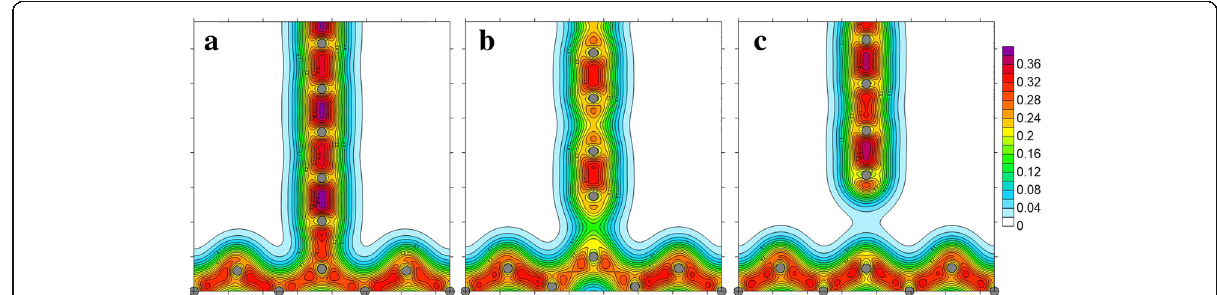
Fig. 6 Distribution of the electron density at various stages of tension of nano-elements: a is the initial state; b is the moment of instability; c is the moment after restoration of equilibrium (points A, B, C on Fig. 4,